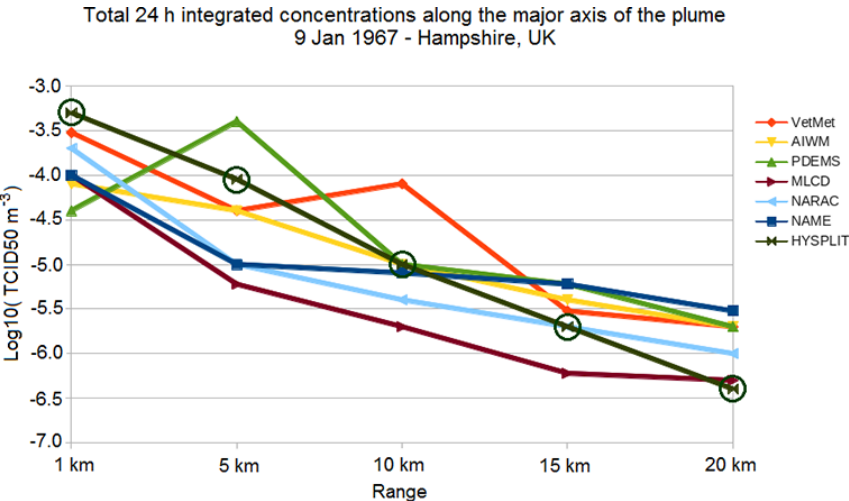
Figure 3. Total integrated concentrations (24h) of FMD for 1969 Hampshire case study as a function of distance from emission source (i.e. primary infected farm). The graph shows the results of all 6 models which participated in the 2010 intercomparison [data from Table 3 Gloster et al. 2010], along with the concentrations derived from the new FMD option within HYSPLIT (dark green line with circles). As can be seen all 7 models agree well, with concentrations falling off with distance as expected. The modelling groups include; VetMet, Denmark; AIWM, Australia; PDEMS, New Zealand; MLCD, Canada; NARAC, USA & NAME, UK. The HYSPLIT line appears near linear because its concentration plume, hence plume axes, is quite uniform leading to a consistent decrease in concentration with